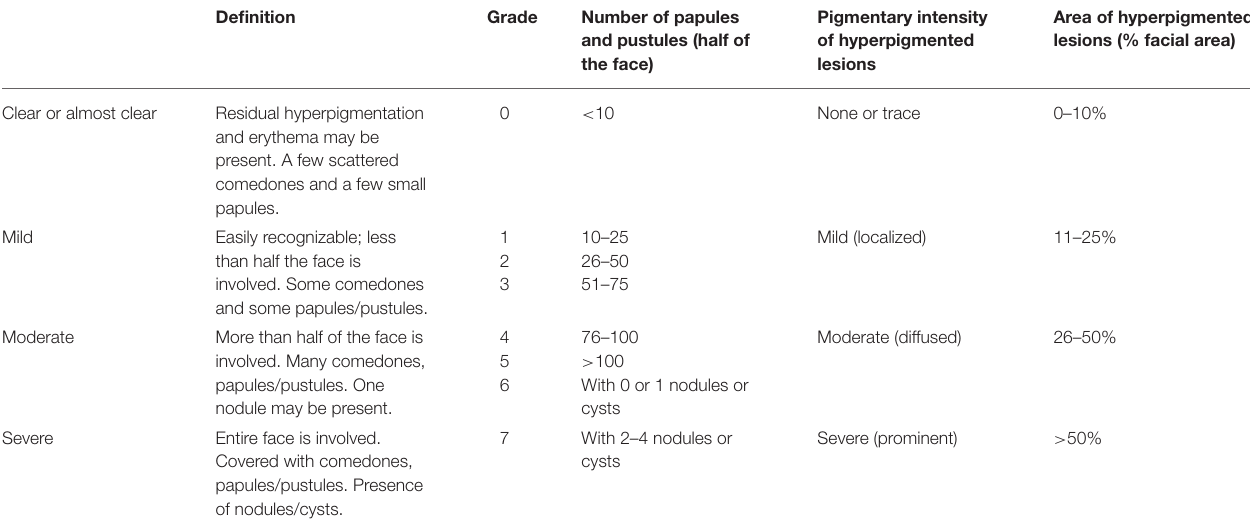
TABLE 1 | Investigator’s assessment scale (IGA) for acne severity combined with post-inflammatory hyperpigmentation